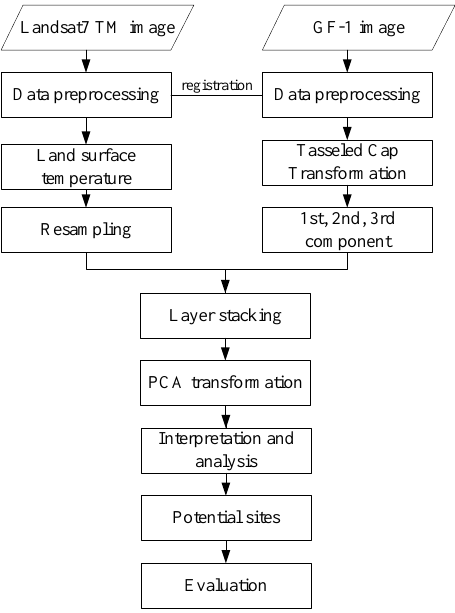
Figure 2. Flow chart of experiment